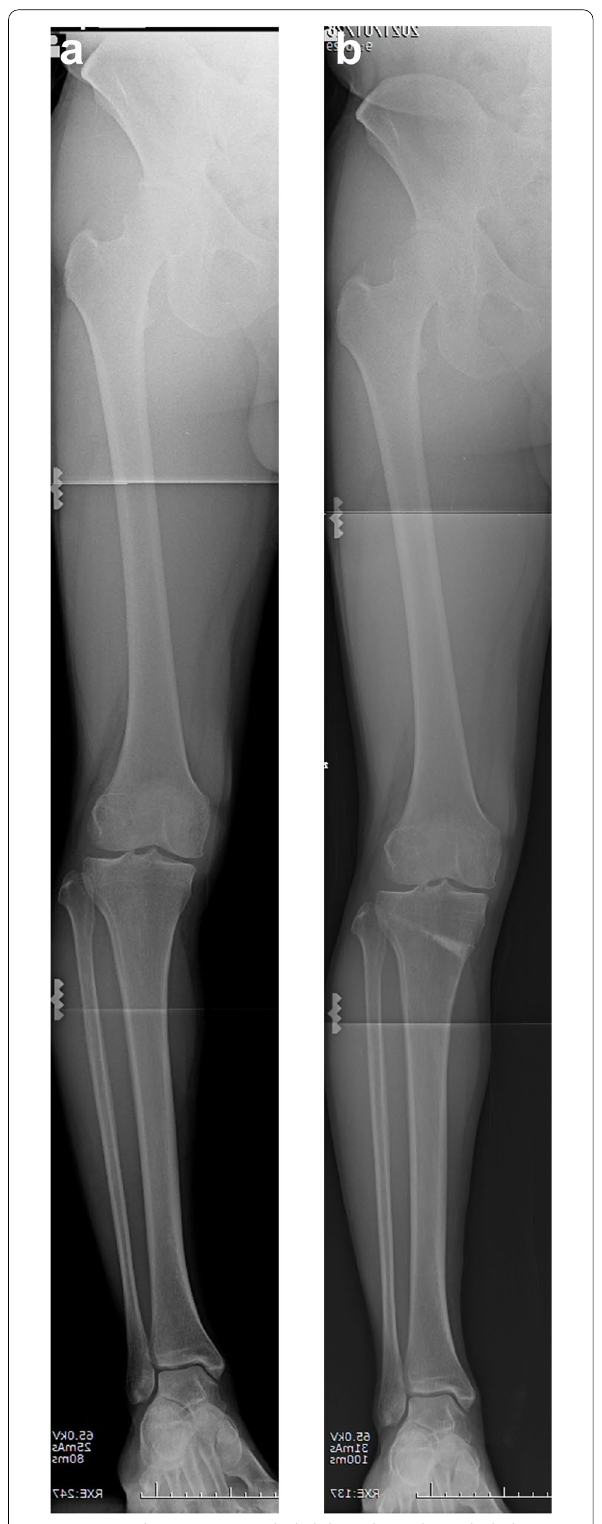
Fig. 2 Pre- and post-operative hole bilateral standing whole-leg radiographs. a Preoperative radiograph, b Post-operative (final follow-up)